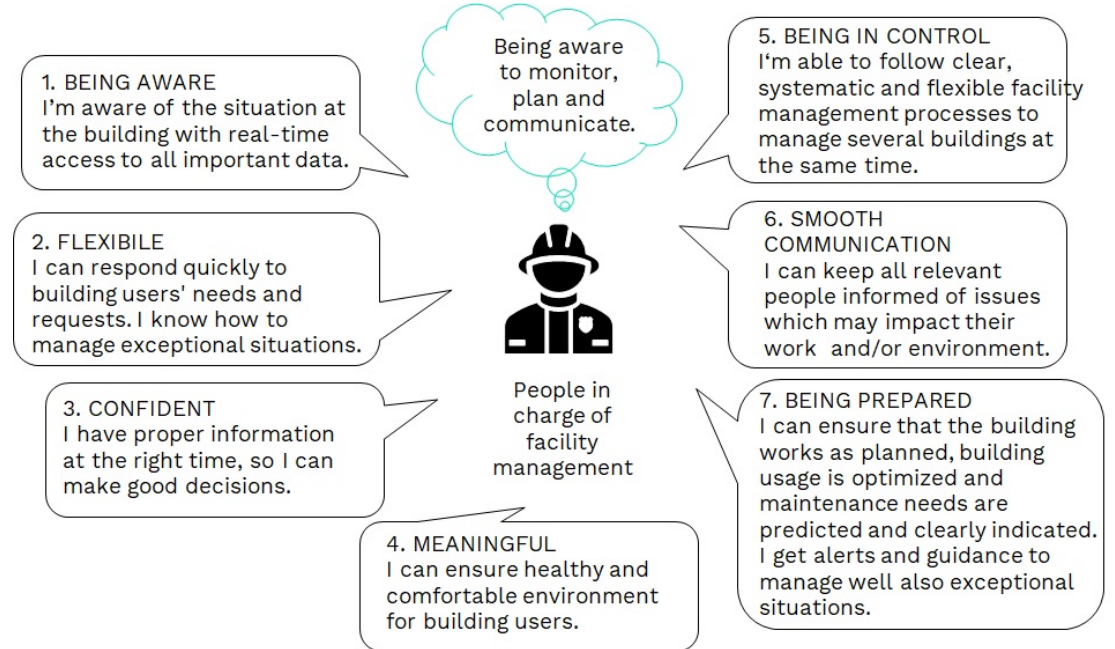
Figure 5. The UX vision and UX goals for people in charge of facility management.